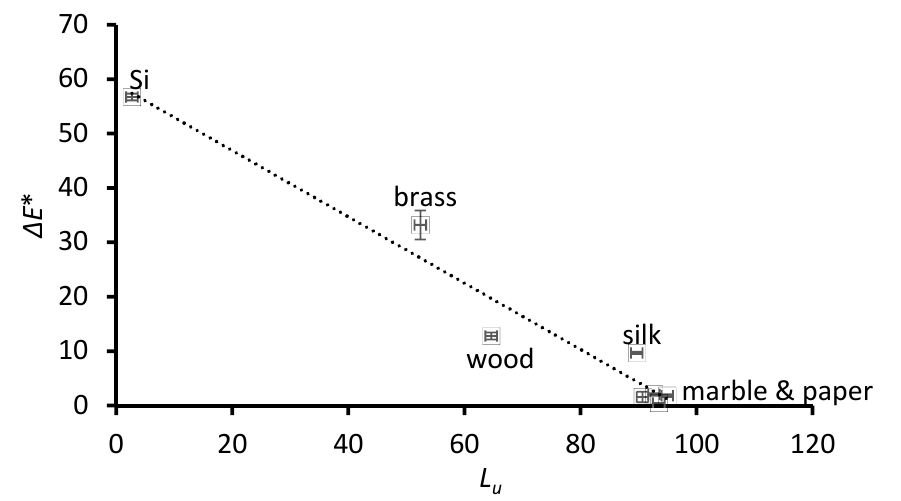
Figure 3. Color change ( ∆ E *) vs. the brightness component ( L u *) of the uncoated, bare substrates. Data points were fitted with a linear function to guide the eye.